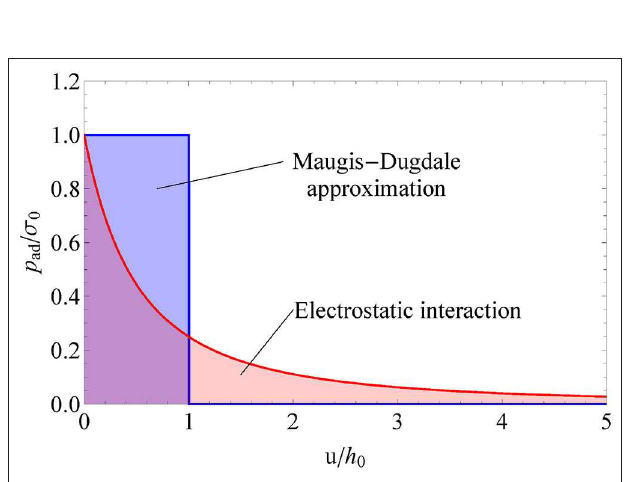
FIGURE 3 | Typical electrostatic attraction force law replaced by a Maugis step function law, plotted in dimensionless form with